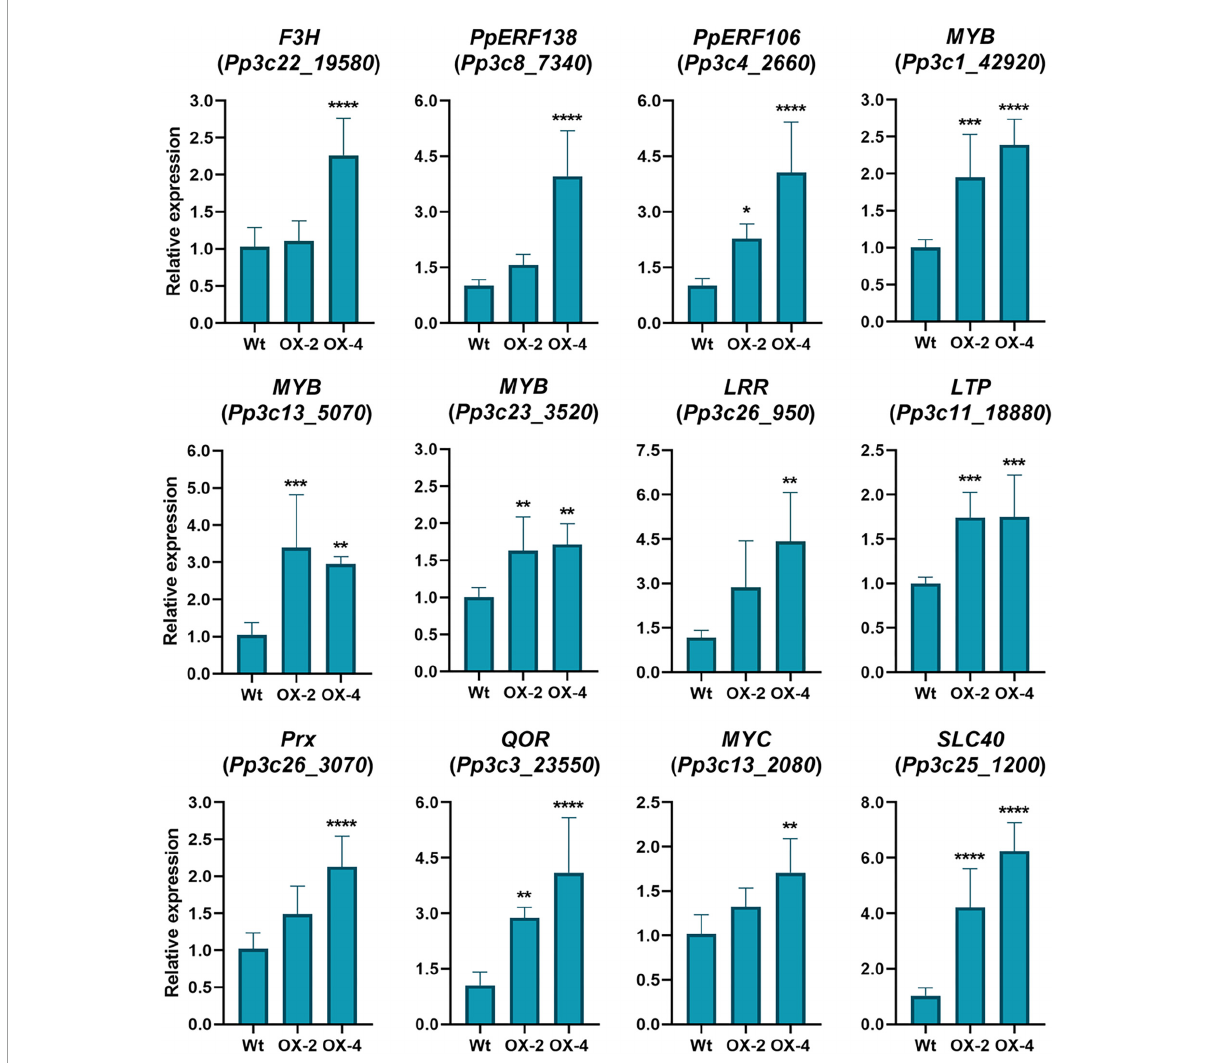
FIGURE6 Expression levels of defense genes in control wild-type and PpERF24 overexpressing plants. Transcript levels in control PpERF24 overexpressing lines were expressed relative to the corresponding levels in control wild-type samples, using Ubi2 as reference gene. Results are reported as means ± standard deviation (SD) of four samples for each treatment. Asterisks indicate a statistically significant difference between wild-type and overexpressing plants (Student’s t -test, * P ≤ 0.05; ** P ≤ 0.01; *** P < 0.001; **** P <